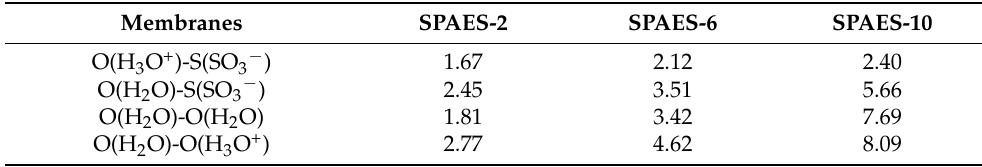
Table 3. Calculated coordination number at 300 K and 1 atm, λ =